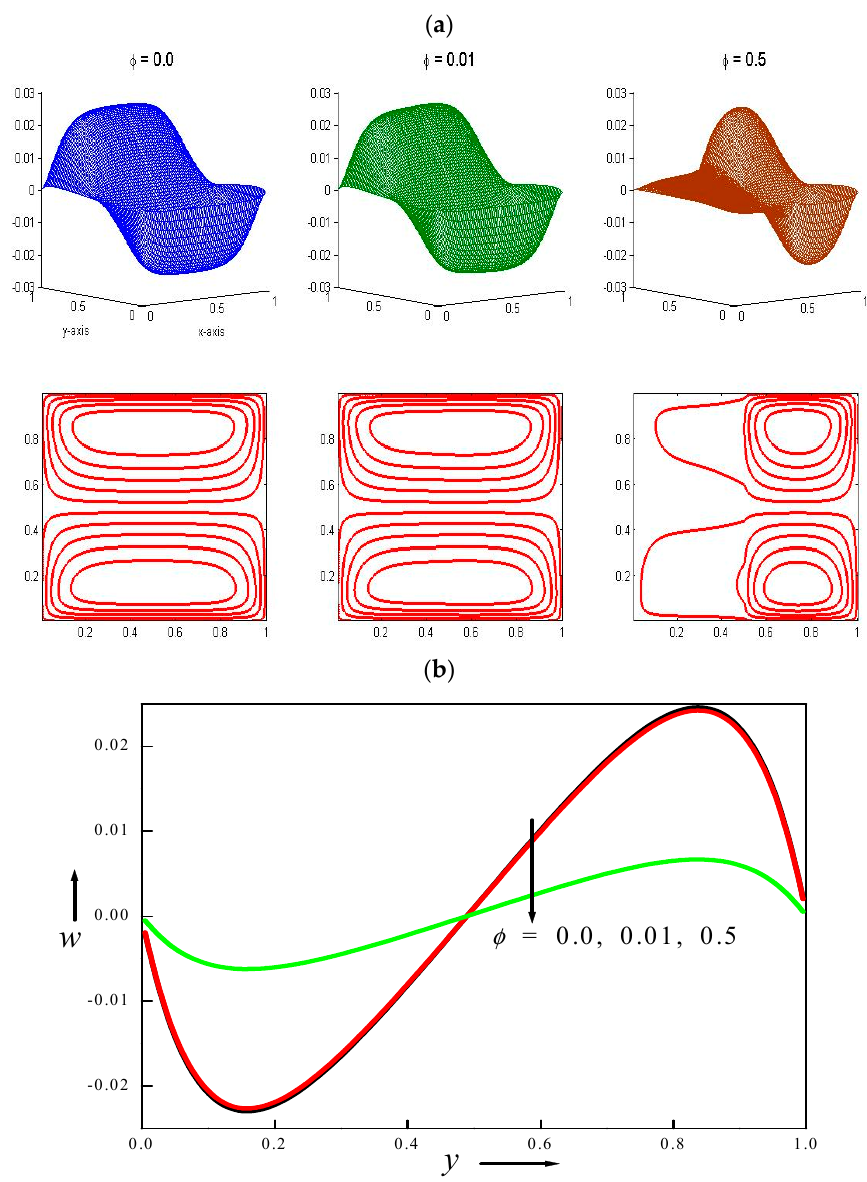
Figure 4. Velocity ( a ) contours and ( b ) profiles for altered solid volume fraction.